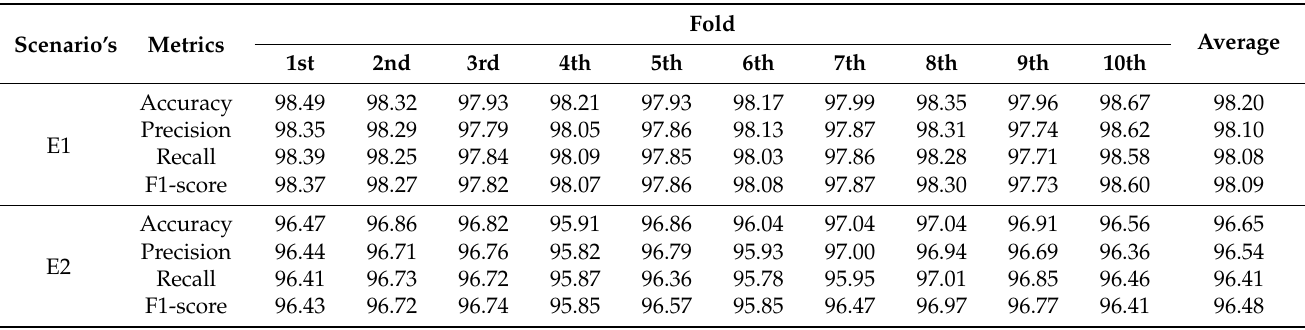
Table 5. The results of the STC-NLSTMNet model’s performance on the Multi-environment dataset on LOS.